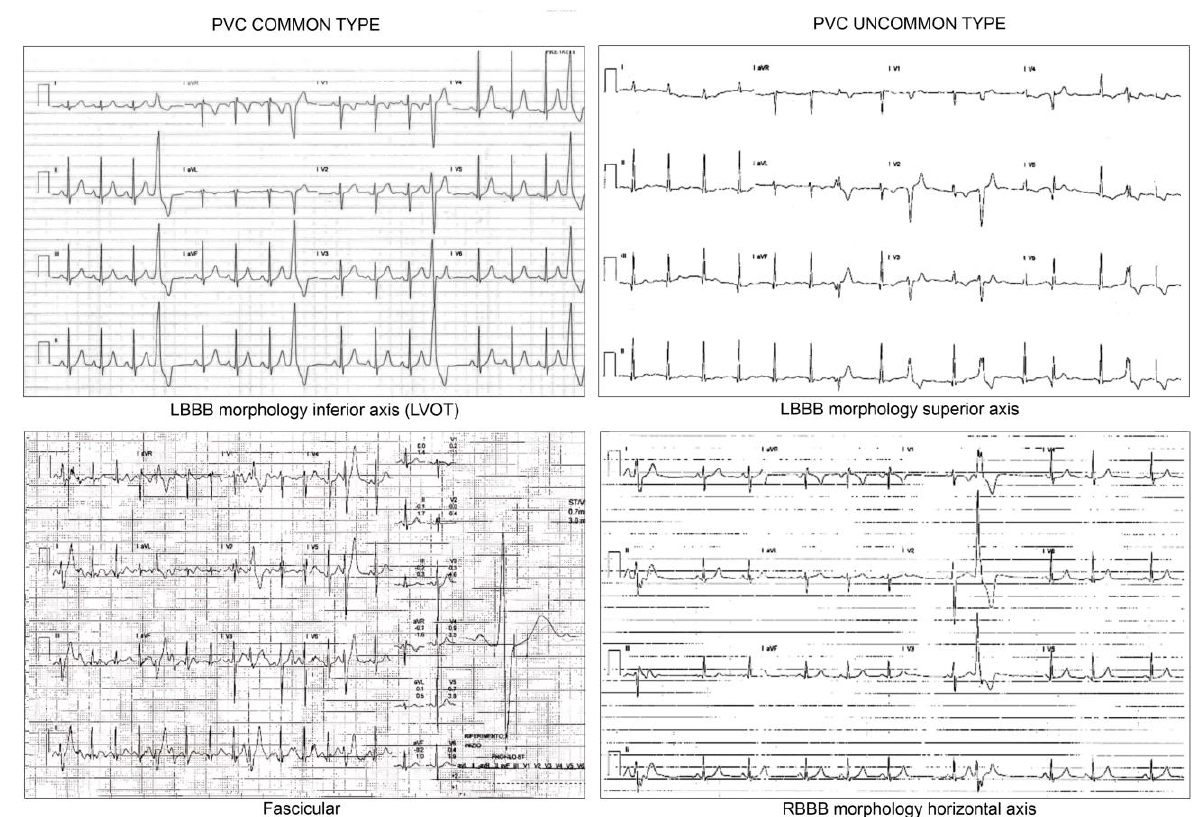
Figure 1. ECG pattern morphologies. Legend: LBBB: left bundle branch block; LVOT: left ventricular outflow tract; RBBB: right bundle branch block.